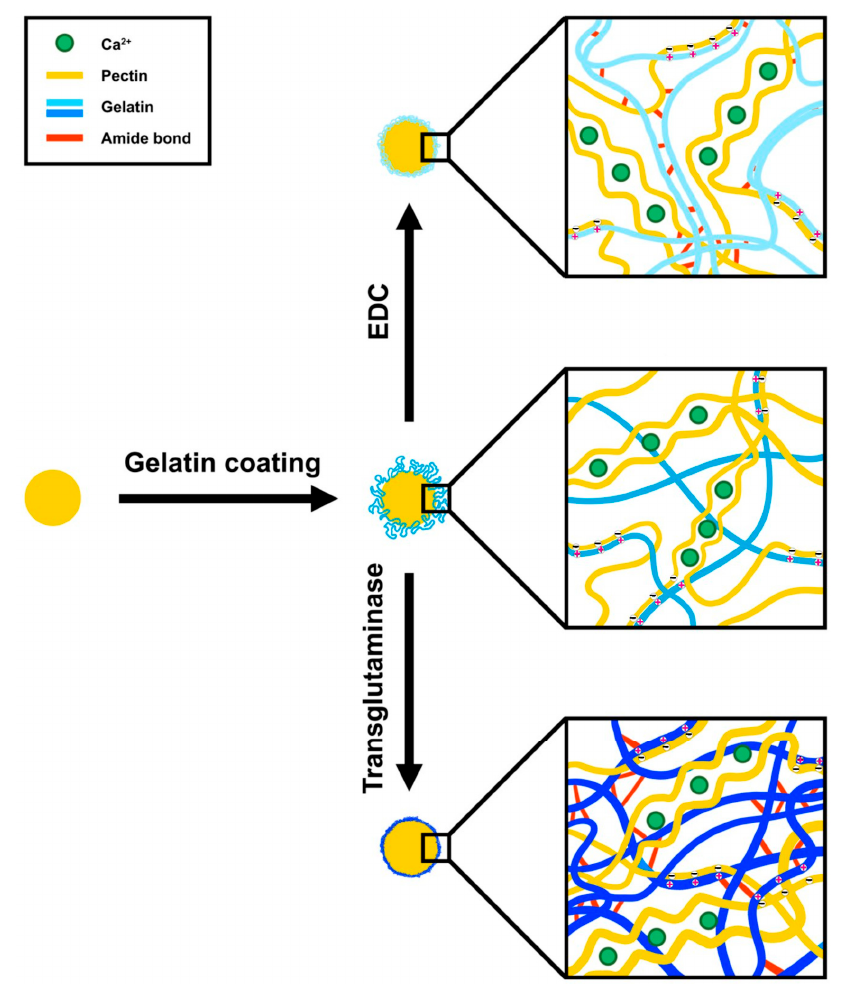
Gelatin contains an abundance of positively charged residues, which can be utilized to form polyelectrolyte complexes that stabilize the structure of a microsphere [23]. The catalysis mechanism of EDC causes pectin to interact with gelatin at the microspheres surface, resulting in amide bonds formation. On the other hand, crosslinking via transglu ‐ taminase results in gelatin ‐ gelatin interactions, leading to a condensed gelatin coating (Scheme 2). The catalysis mechanism differences contributed to the slight size differences (Figure 2). Studies regarding the functionalization of pectin have also shown that RGD ‐ Figure 2. Size of different types of microspheres in DI water. Figure 2. Size of different types of microspheres in DI water. pectin microspheres are larger than unmodified pectin microspheres [28].